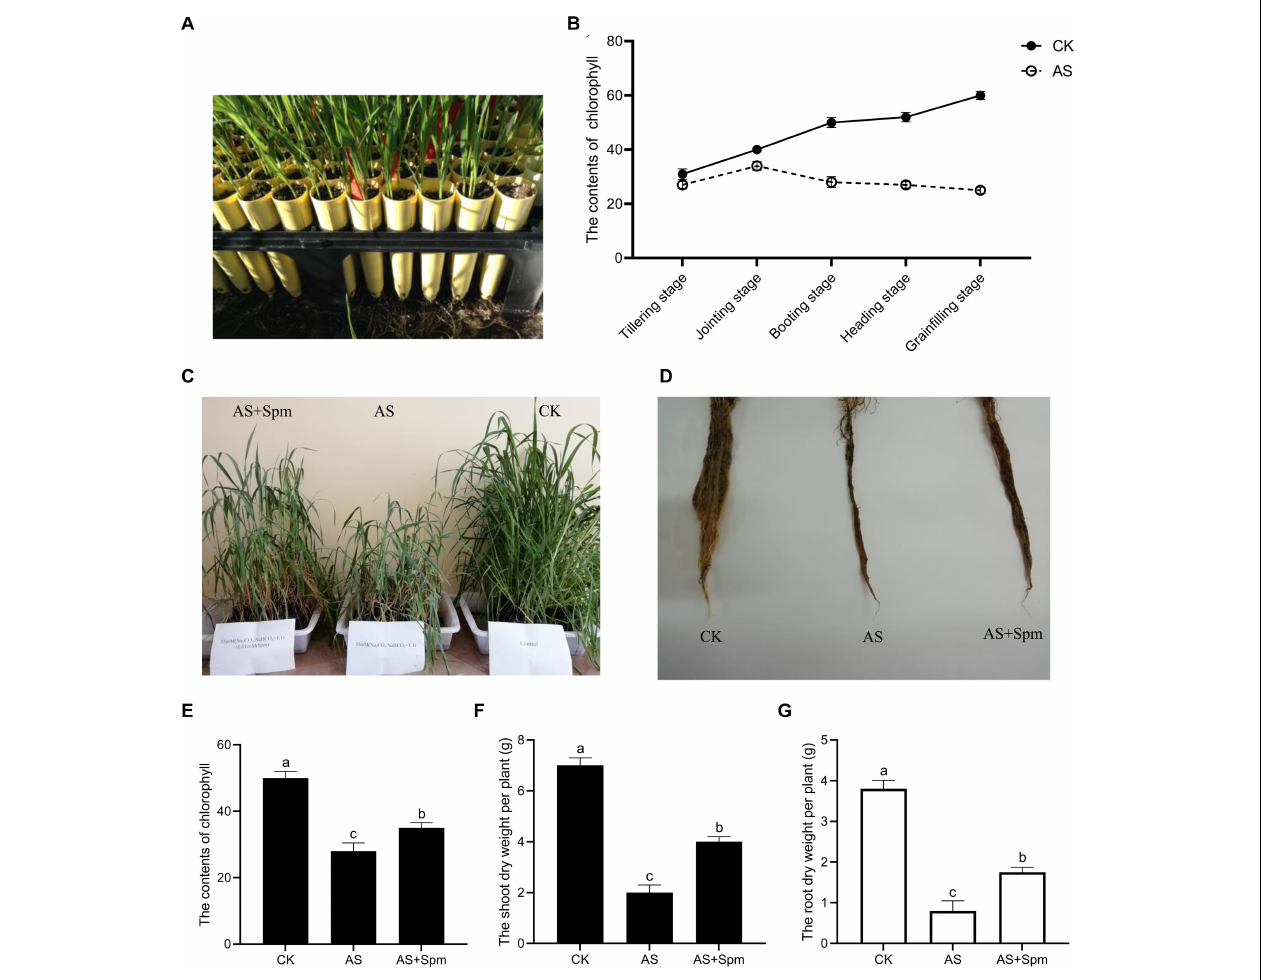
FIGURE 1 | Effects of exogenous spermine on oat growth under alkali stress at booting stage. (A) The cone-tainer planting method. (B) Effects of alkali stress on chlorophyll contents at varied stages. (C) Image related to the effects of exogenous spermine on shoot growth under alkali stress at booting stage. (D) Image related to the effects of exogenous spermine on root growth under alkali stress at booting stage. (E) Effects of spermine on chlorophyll contents under alkali stress at booting stage. (F) Effects of spermine on shoot dry weight per plant under alkali stress at booting stage. (G) Effects of spermine on root dry weight per plant under alkali stress at booting stage. CK, control; AS, alkali stress (35 mmol.L − 1 Na 2 CO 3 :NaHCO 3 = 1:1); AS + Spm, 35 mmol.L − 1 Na 2 CO 3 :NaHCO 3 + 0.01 mmol.L − 1